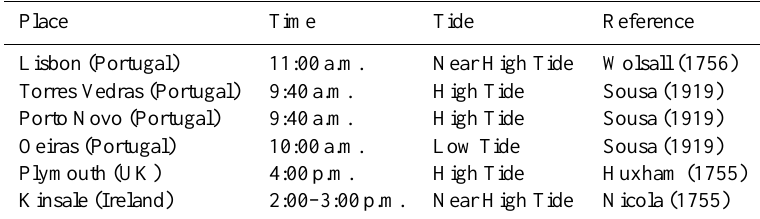
Table 2. Historical observations of the